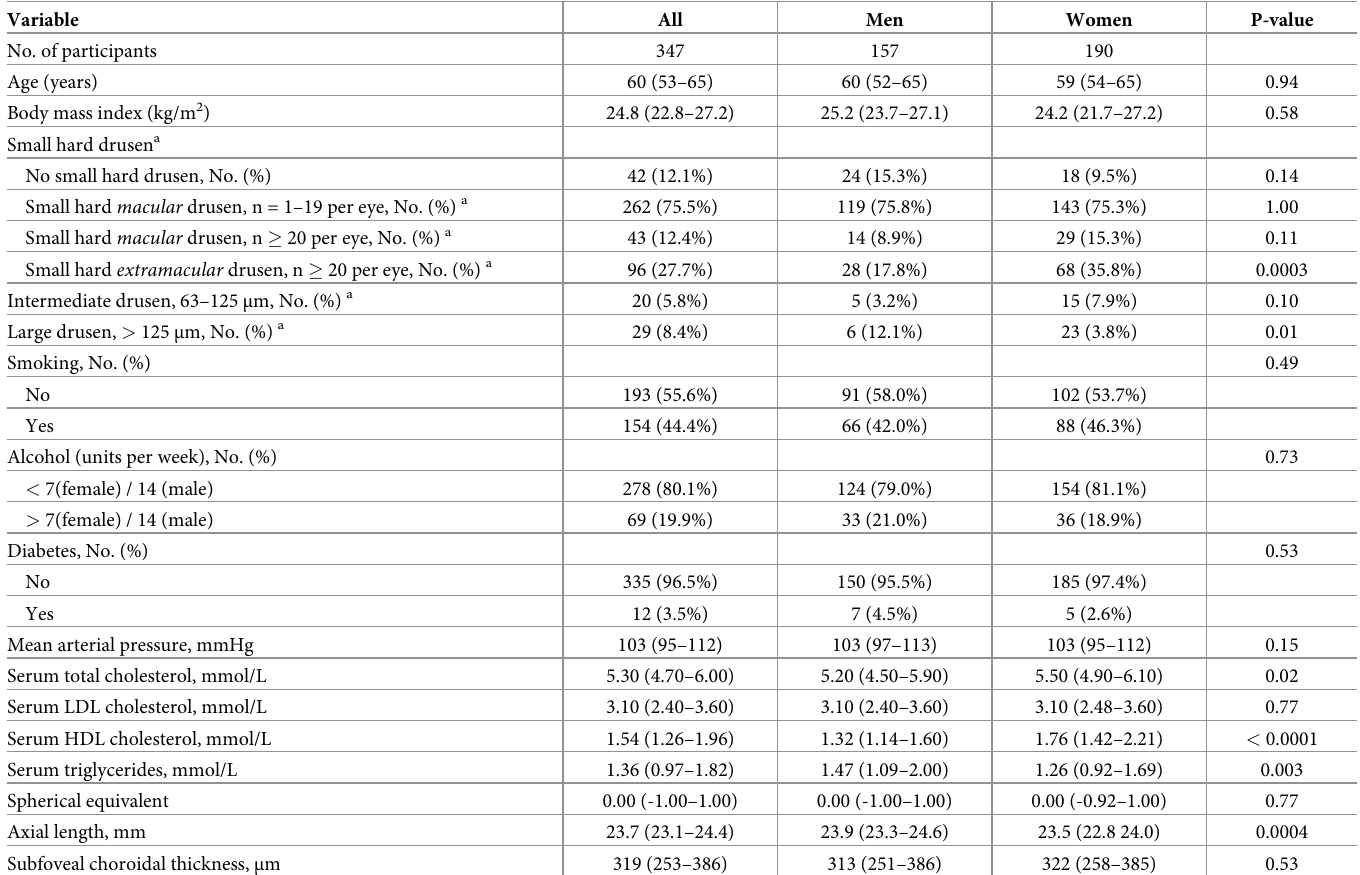
Table 1. Characteristics of the study